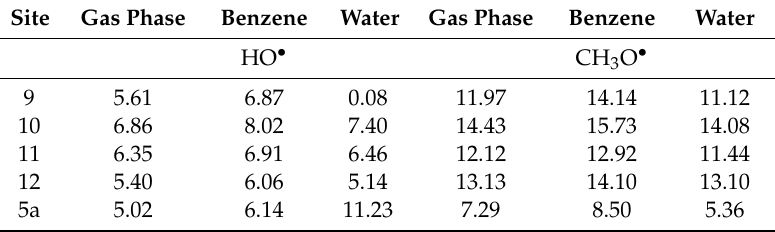
Table 3. ∆ G ‡ HAT (kcal mol − 1 ) in the gas phase, benzene, and water, for the scavenging of HO •